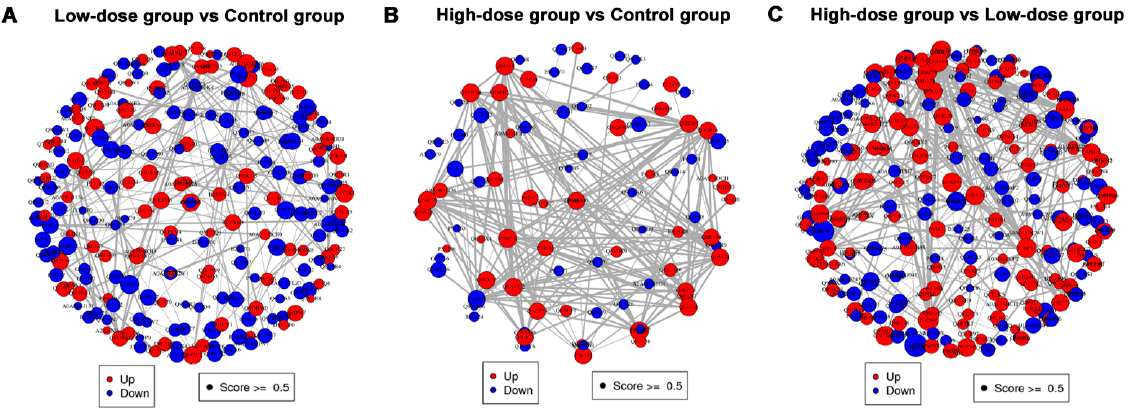
Figure 6. PPI networks of differentially expressed proteins (DEPs) between different groups. ( A ) low-dose group vs. control group. ( B ) high-dose group vs. control group; ( C ) high-dose vs. low-dose group. Red nodes represent up-regulated proteins and blue nodes represent down-regulated proteins.